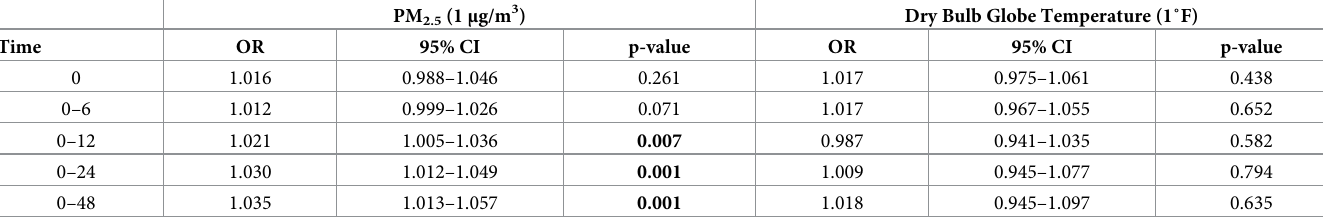
Table 3. Adjusted odds ratios of rescue bronchodilator use for PM 2.5 (1- μ g/m 3 ) and temperature (1˚F) in the same